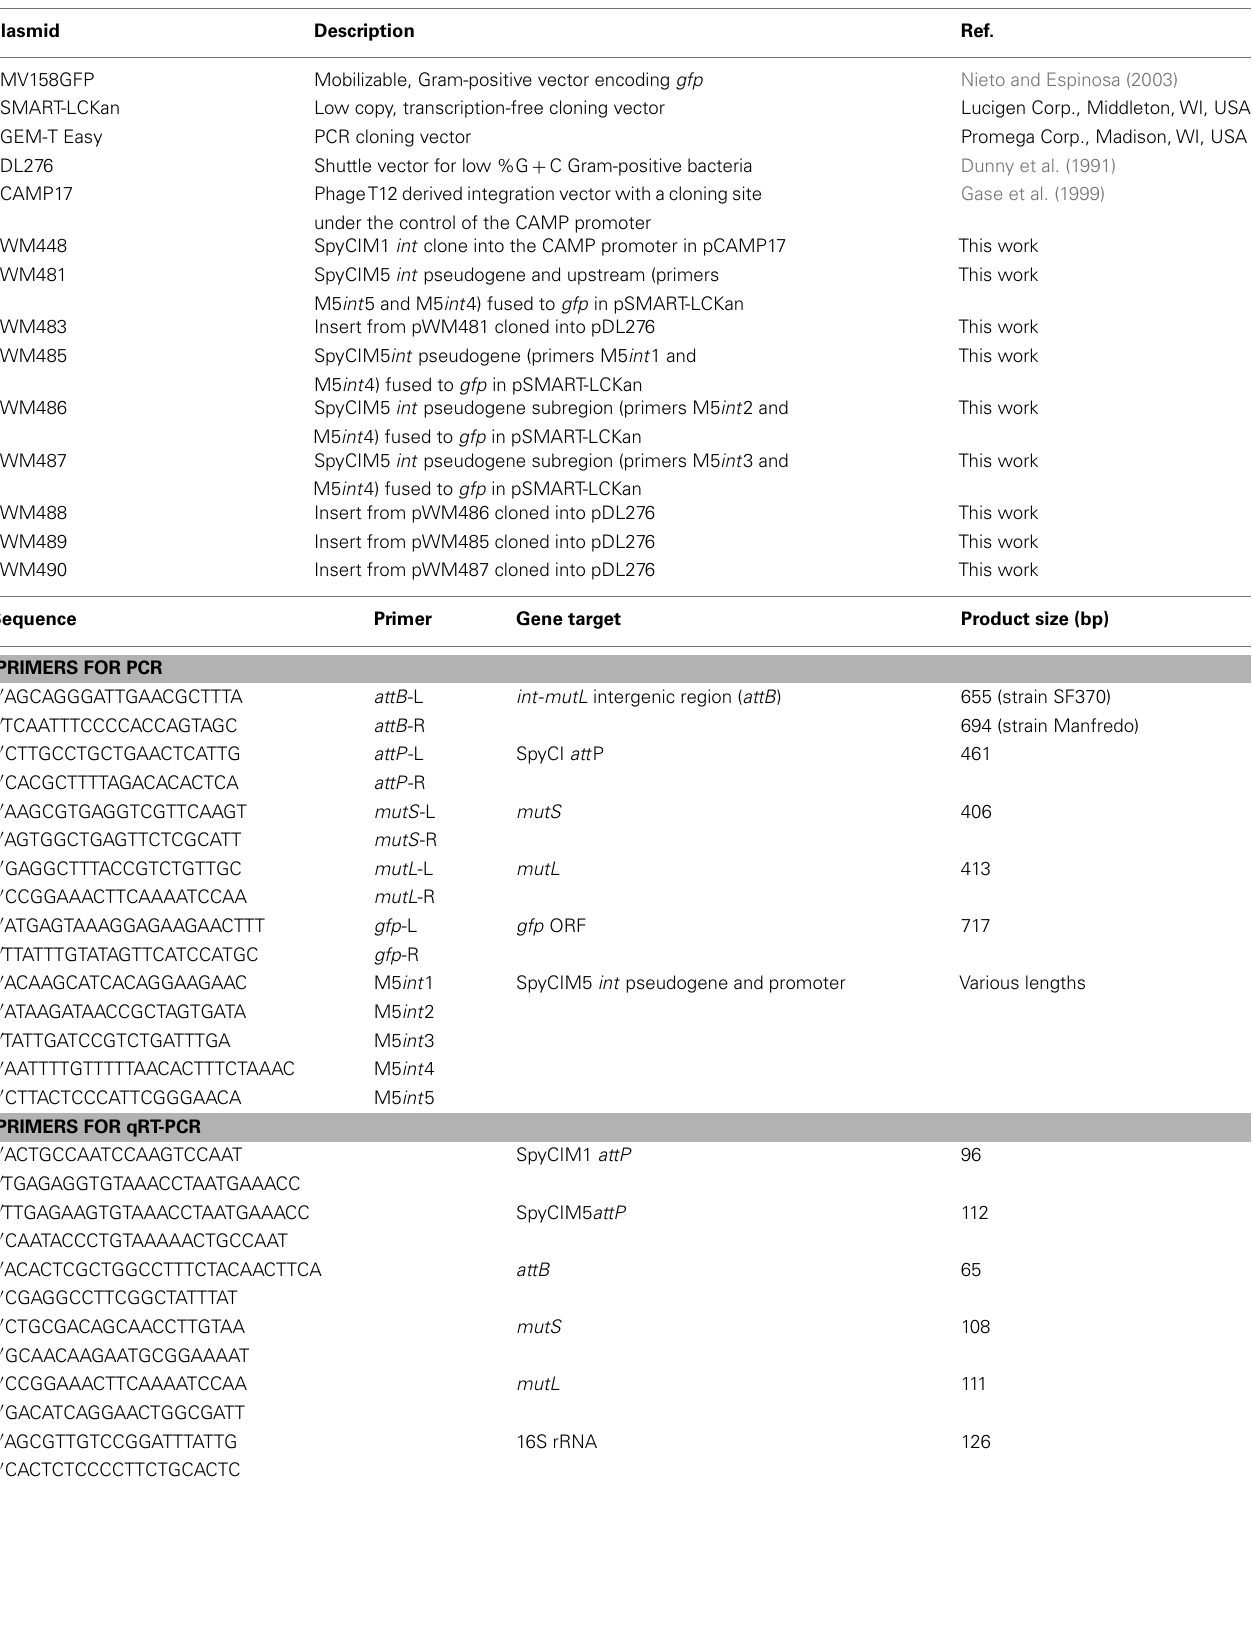
Table 2 | Plasmids and PCR